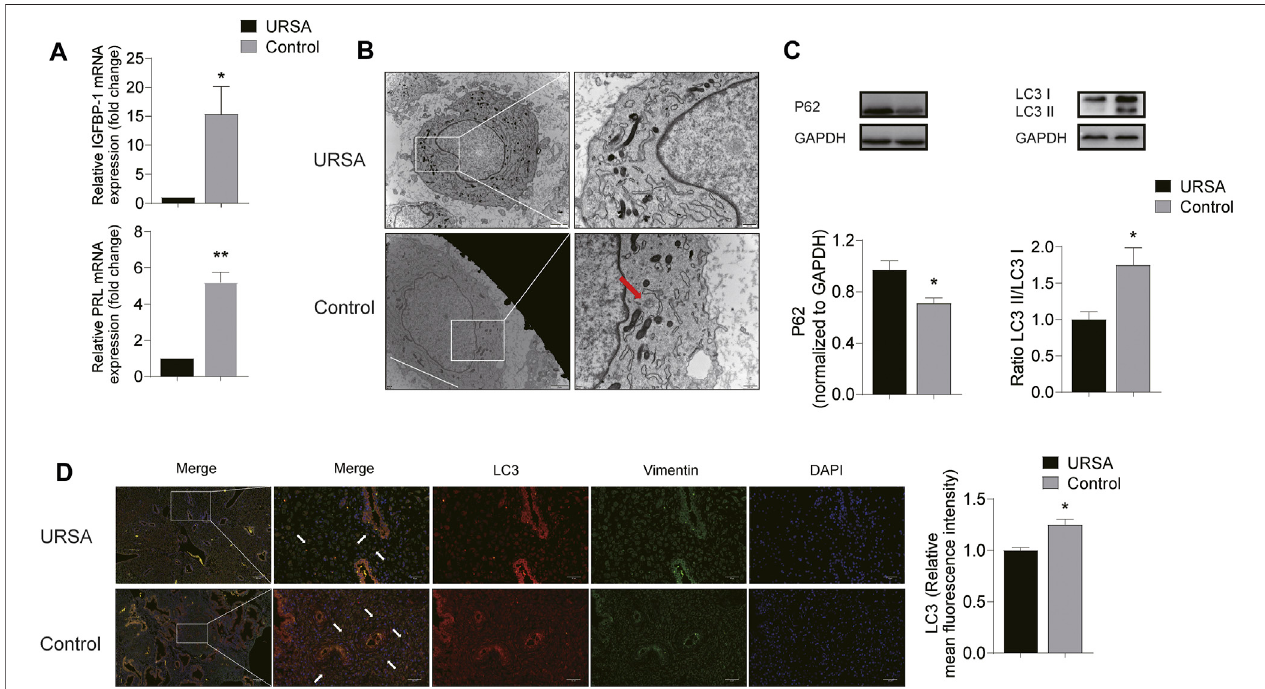
FIGURE 3 | Autophagy was inhibited in the decidua tissues of URSA with impaired decidualization. (A) mRNA of IGFBP1 and PRL in the URSA group and control group; (B) TheautophagosomesintheURSAgroupandcontrolgroupobservedbyTEM(scalebar:2 μ mand500 nm); (C) TheexpressionlevelsofLC3II/LC3Iandp62 in the decidua tissue used by Western blot; (D) Immuno fl uorescence co-location of LC3 and vimentin, and the expression of LC3 (scale bar: 200 μ m and 50 um). * p < 0.05 vs. URSA